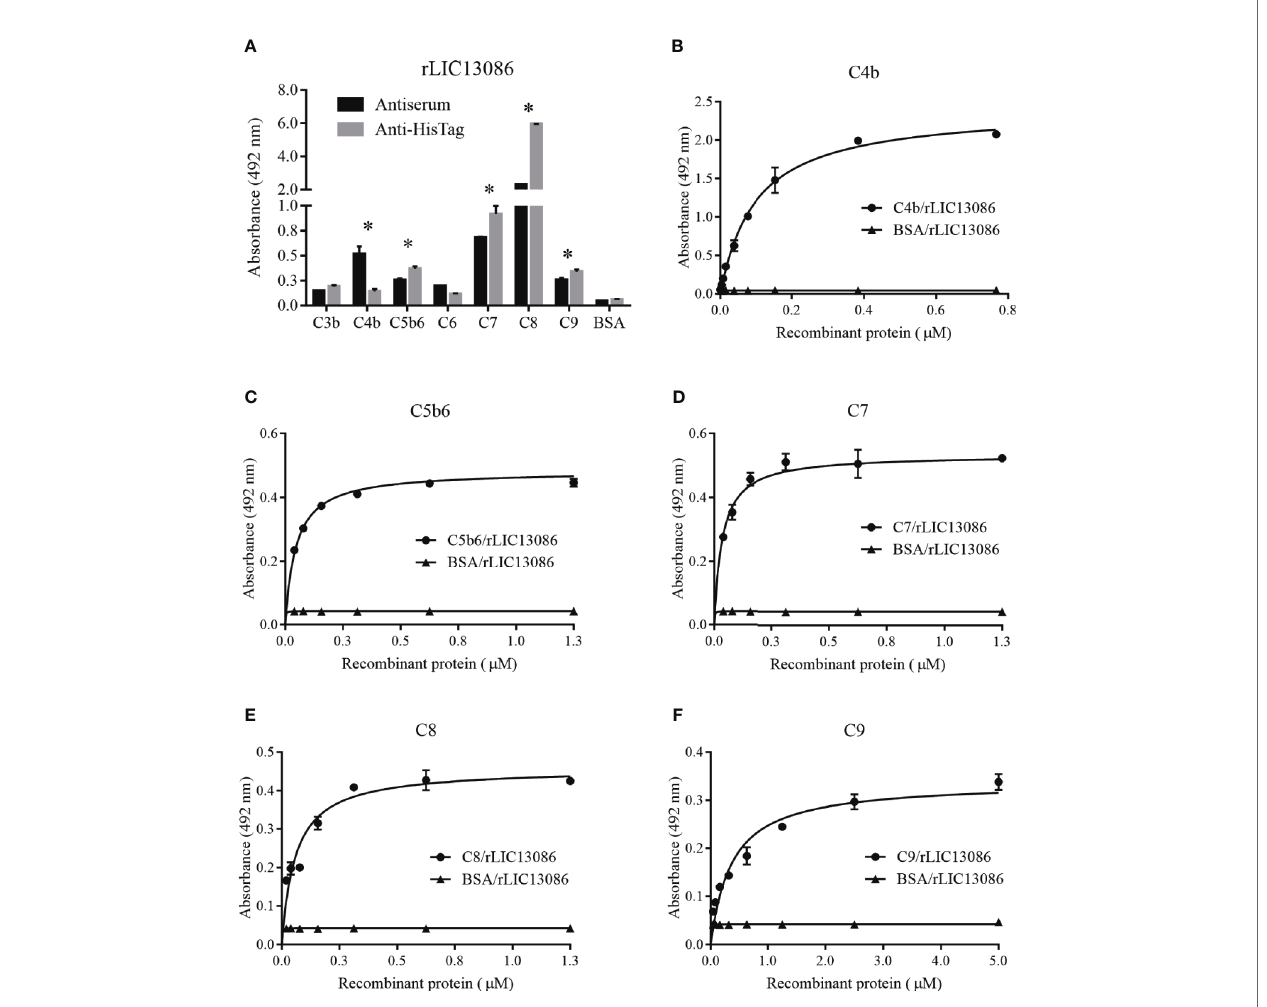
FIGURE 8 | Interaction of rLIC13086 with complement system components. (A) Complement system components were coated onto ELISA plates (1 m g) and incubated with rLIC13086 (1 m g) for 2 h at 37°C. Detection was performed with HRP-conjugated anti-HisTag mAb (1:10,000) or anti-rLIC13086 antiserum (1:5,000) and secondary HRP-conjugated anti-mouse IgG (1:5,000). (B) Coated C4b, (C) C5b6, (D) C7, (E) C8, and (F) C9 were incubated with different concentrations of rLIC13086 (0 – 5 m M) for 2 h at 37°C and detected with HRP-conjugated anti-HisTag mAb (1:10,000). BSA was used as negative control. The bars represent the means of three different experiments in triplicates with the corresponding standard deviation. * Indicates signi fi cant difference calculated by Student t- test with p-values <